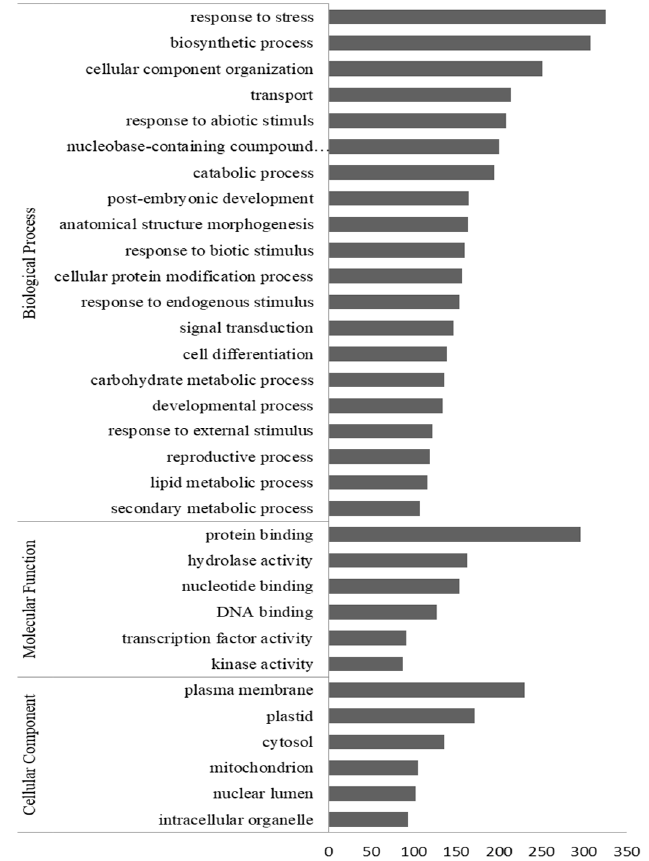
Figure 4. Gene ontology (GO) categorization of transcripts up-regulated (fold change > 1.5; p < 0.05) in mycorrhizal roots of Oeceoclades maculata. Bars indicate the number of reads. X-axis, the number of reads.